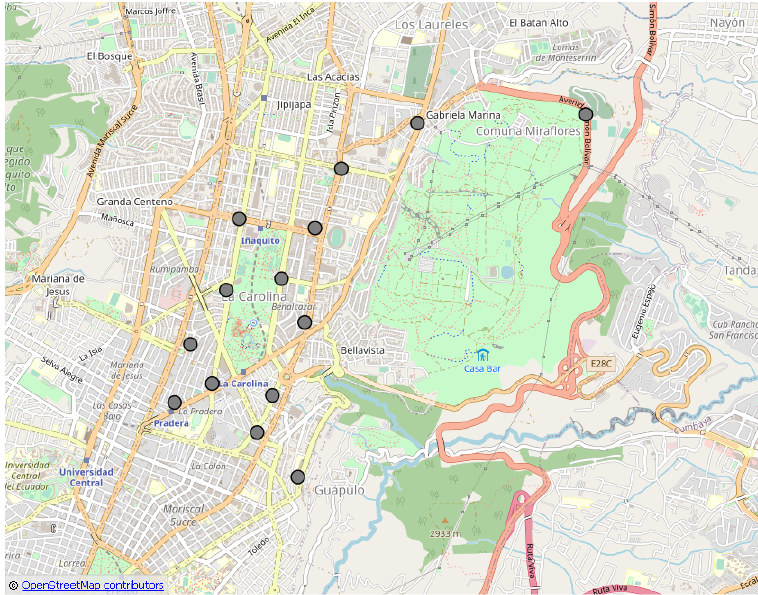
Figure 13. Way-points O k (gray